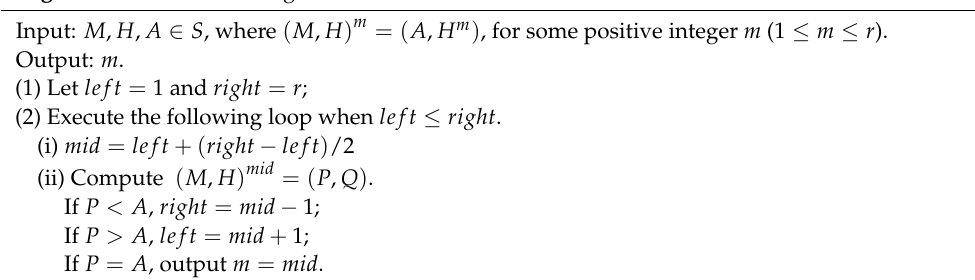
Algorithm 2: RM Attack